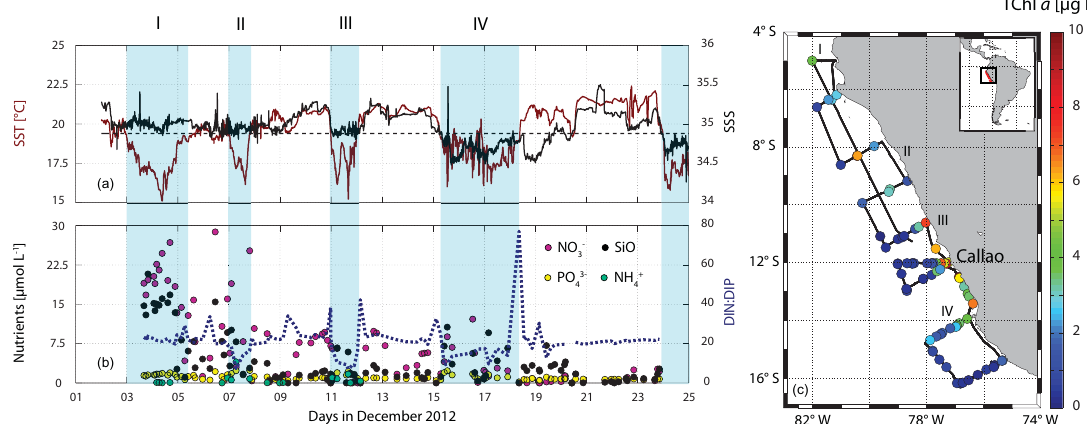
Figure 1. Ambient parameters during the M91 cruise: SST (dark red) and sea surface salinity (SSS) (black) in panel (a) with the dashed line as the mean SST. Nutrients (purple is nitrate – NO − ; yellow is phosphate – PO 3 − ; black is silicate – SiO 2 ; light cyan is ammonium – NH + 3 4 with the N to P ratio (dark-blue dashed line) are shown in panel (b) . Total chlorophyll a (TChl a ) is shown in the map in panel (c) . The light-blue shaded areas stand for the regions where SST is below the mean, indicating upwelling of cold water. All M91 data can be accessed at PANGAEA (Hepach et al.,